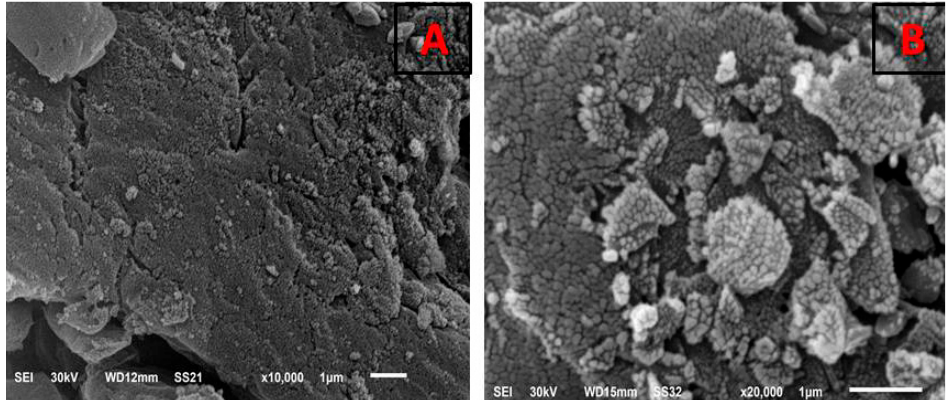
Figure 6. SEM of ( A ) PRD and ( B ) PRD/Zn.